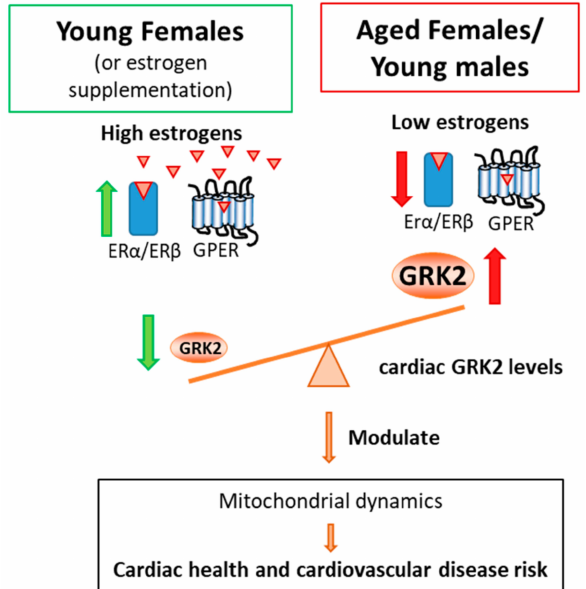
Figure 5. Schematic representation of GRK2 modulation by estrogens in the heart and its parallels with cardiovascular risk. In young female animals, high estrogen levels contribute to maintaining a lower GRK2 dosage whereas, in age-matched males or aged females with lower estrogen levels, higher GRK2 protein levels are detected. Elevated GRK2 levels would decrease GPCR-mediated signaling, and potential estrogen-mediated effects, negatively impinging on mitochondrial fusion markers such as OPA-1 processing which inversely correlate with GRK2 dosage. Thus, the GRK2- mediated modulation of mitochondrial dynamics might potentially contribute to sex- and age- dependent differences in mitochondrial functionality and cardiac